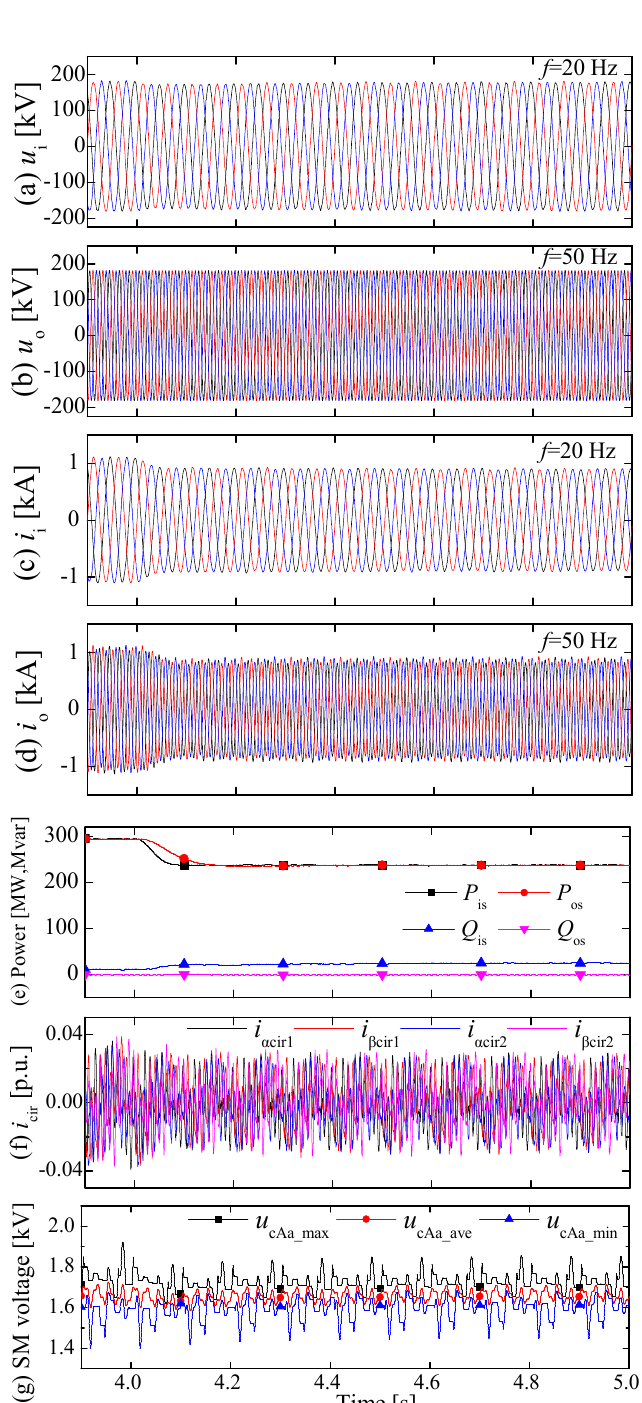
Figure 12. System responses to the wind speed step change: ( a ) voltage on input side; ( b ) voltage on output side; ( c ) current on input side; ( d ) current on output side; ( e ) input and output powers; ( f ) circulating current; and ( g ) instantaneous maximum, average, and minimum values of SM capacitor voltage in arm Aa.